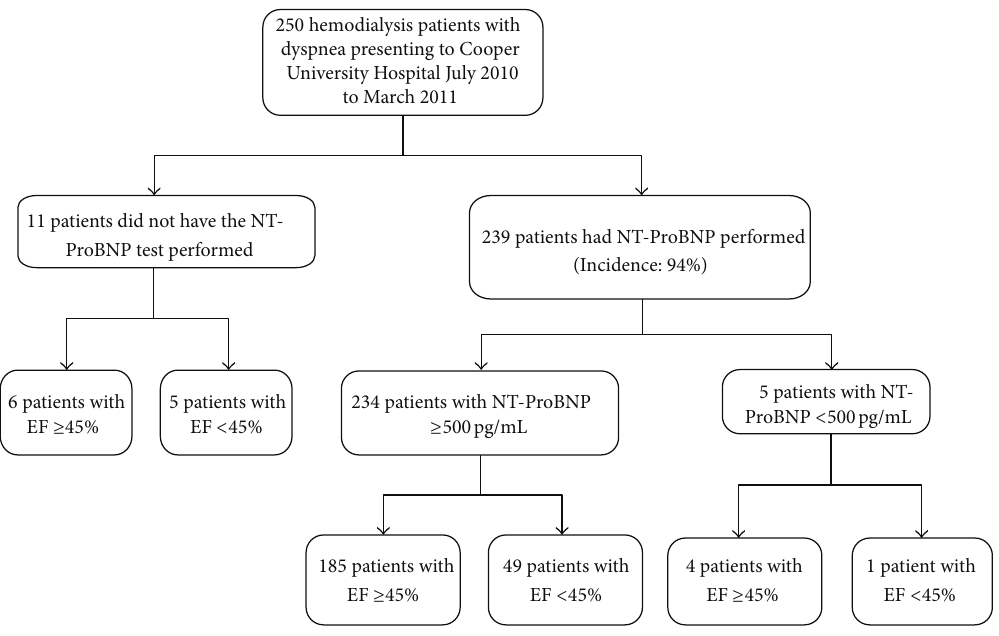
Figure 1: Subject selection of general